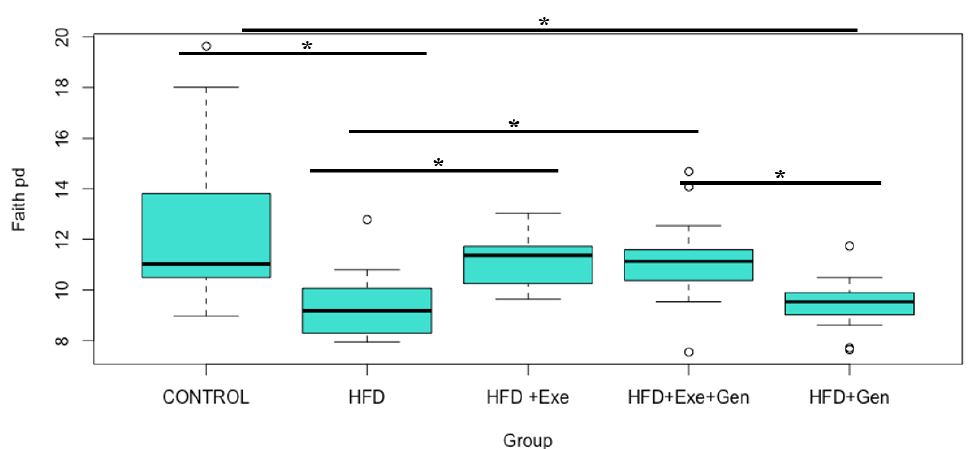
Figure 2. Microbial community richness (Faith’s Phylogenetic Diversity) comparisons in C57BL / 6 mice ( n = 83) after treatment with control; high-fat, high-sugar diet (HFD); HFD + Exercise (HFD + Exe); HFD + Genistein (HFD + Gen); and HFD + Exe + Gen. * denotes significant group differences according to Kruskal–Wallis test ( p < 0.05) after Benjamini–Hochberg correction for multiple comparisons.